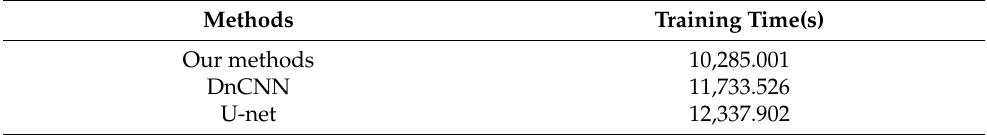
Table 8. Comparison of the three methods in terms of training time.